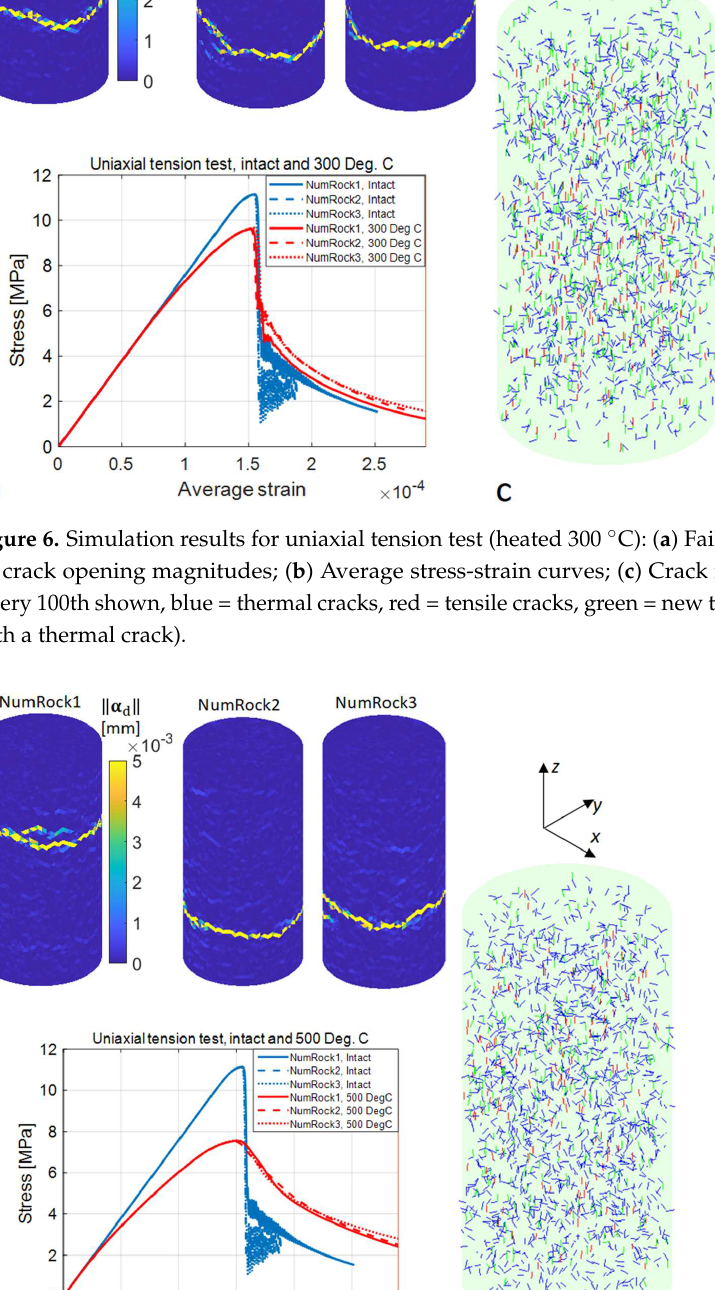
Figure 8. Predicted tensile strengths (normalized with the room temperature values) at different temperatures (the curve for the averaged measurements and the variation bars at 300  C and 500  C for different granites is reproduced after the data in [11]). The present approach predicts the weakening effect correctly. Indeed, the predictions are within the experimental deviation, and very close to the fitted average curve, for sev- eral granites. It should be noted that the experimental curve, 𝑓 (cid:3097) (cid:3295) (cid:3097) (cid:3295)(cid:3116) ⁄ = 0.9912(1 −